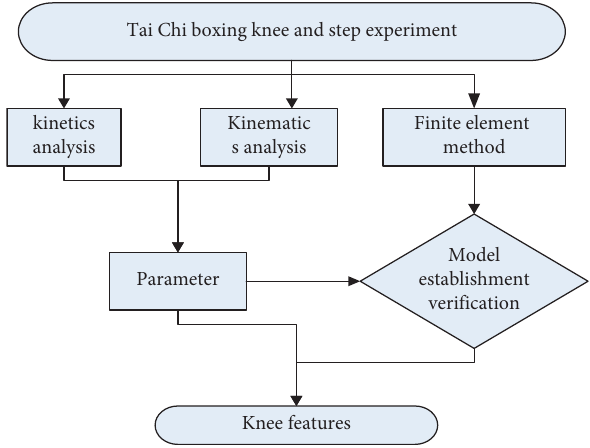
Figure 1: Flowchart of knee movement data